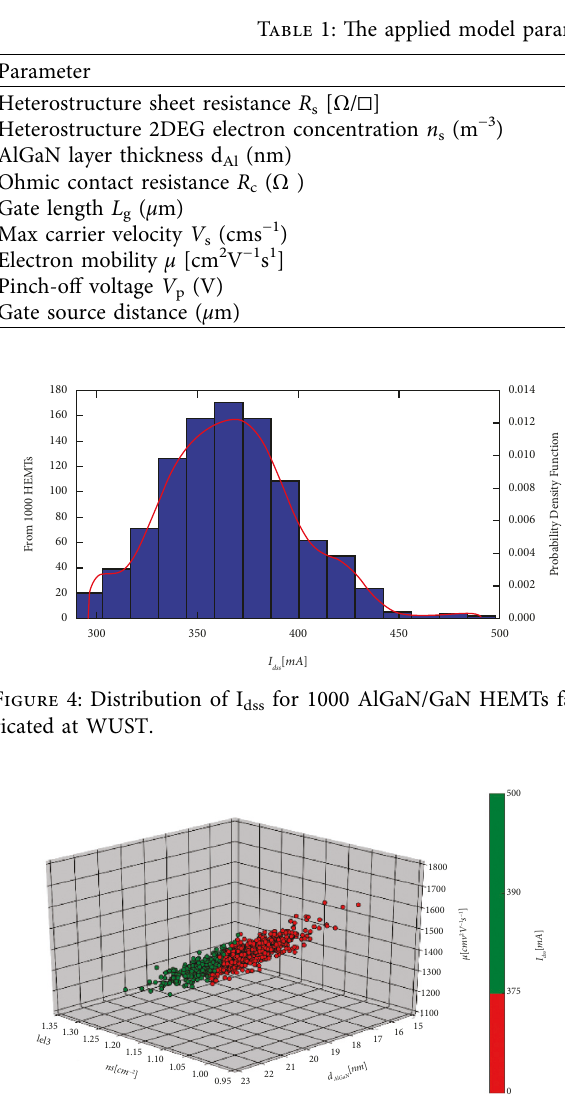
Figure 5: Relationship between saturate drain current, electron mobility, layer thickness, and electron concentration of AlGaN/ GaN HEMT, when stochastic dependencies are omitted.